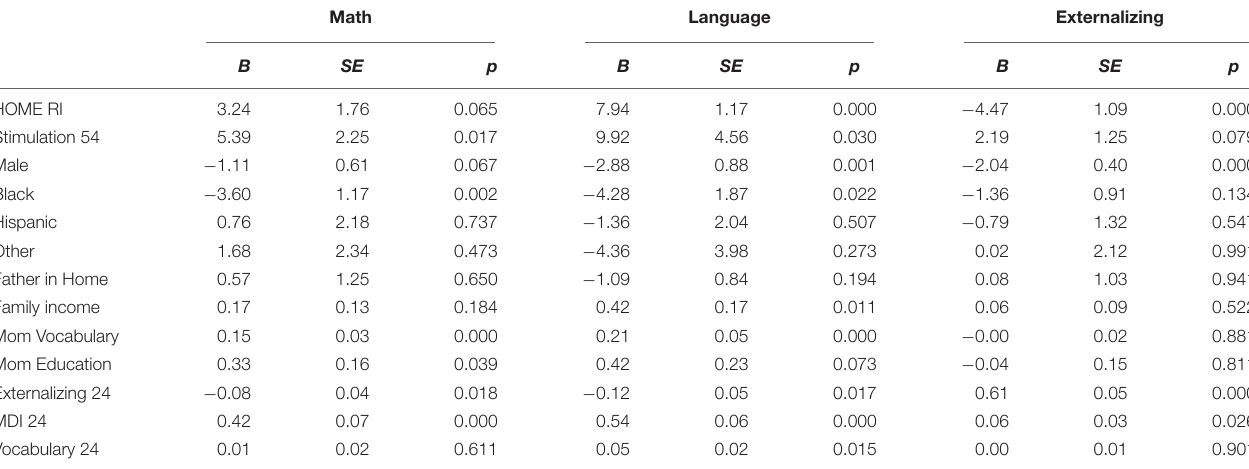
TABLE 4 | Unstandardized estimates from